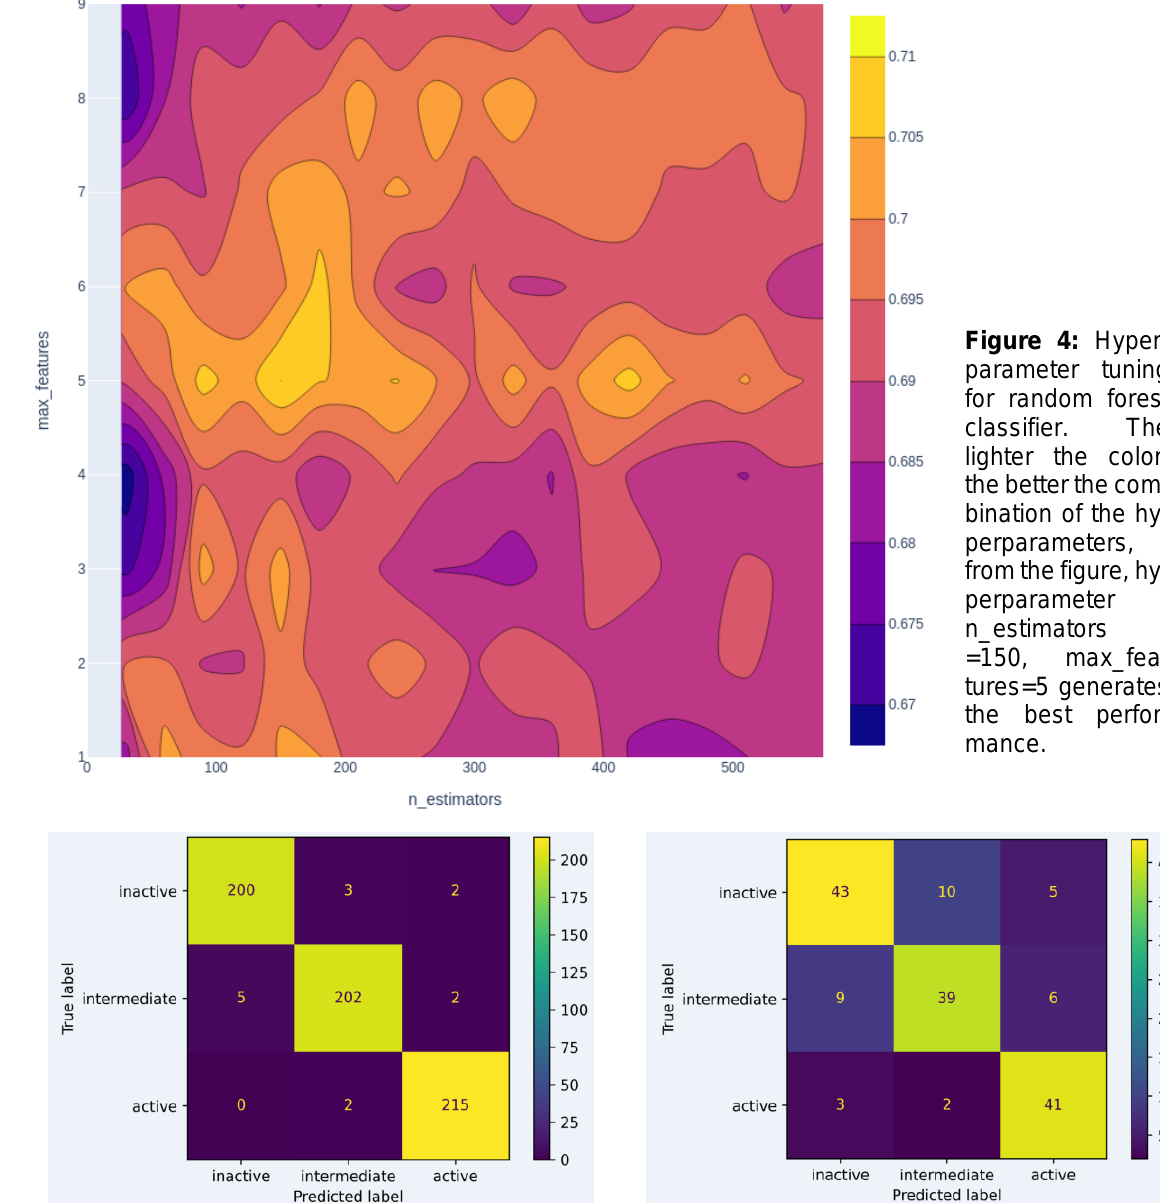
Figure 5: Confusion matrix of experimental versus predicted bioactivity classes of model built using KlekotaRothCount fingerprints as evaluated on training ( A ) and test ( B ) sets after hyperparameter tuning